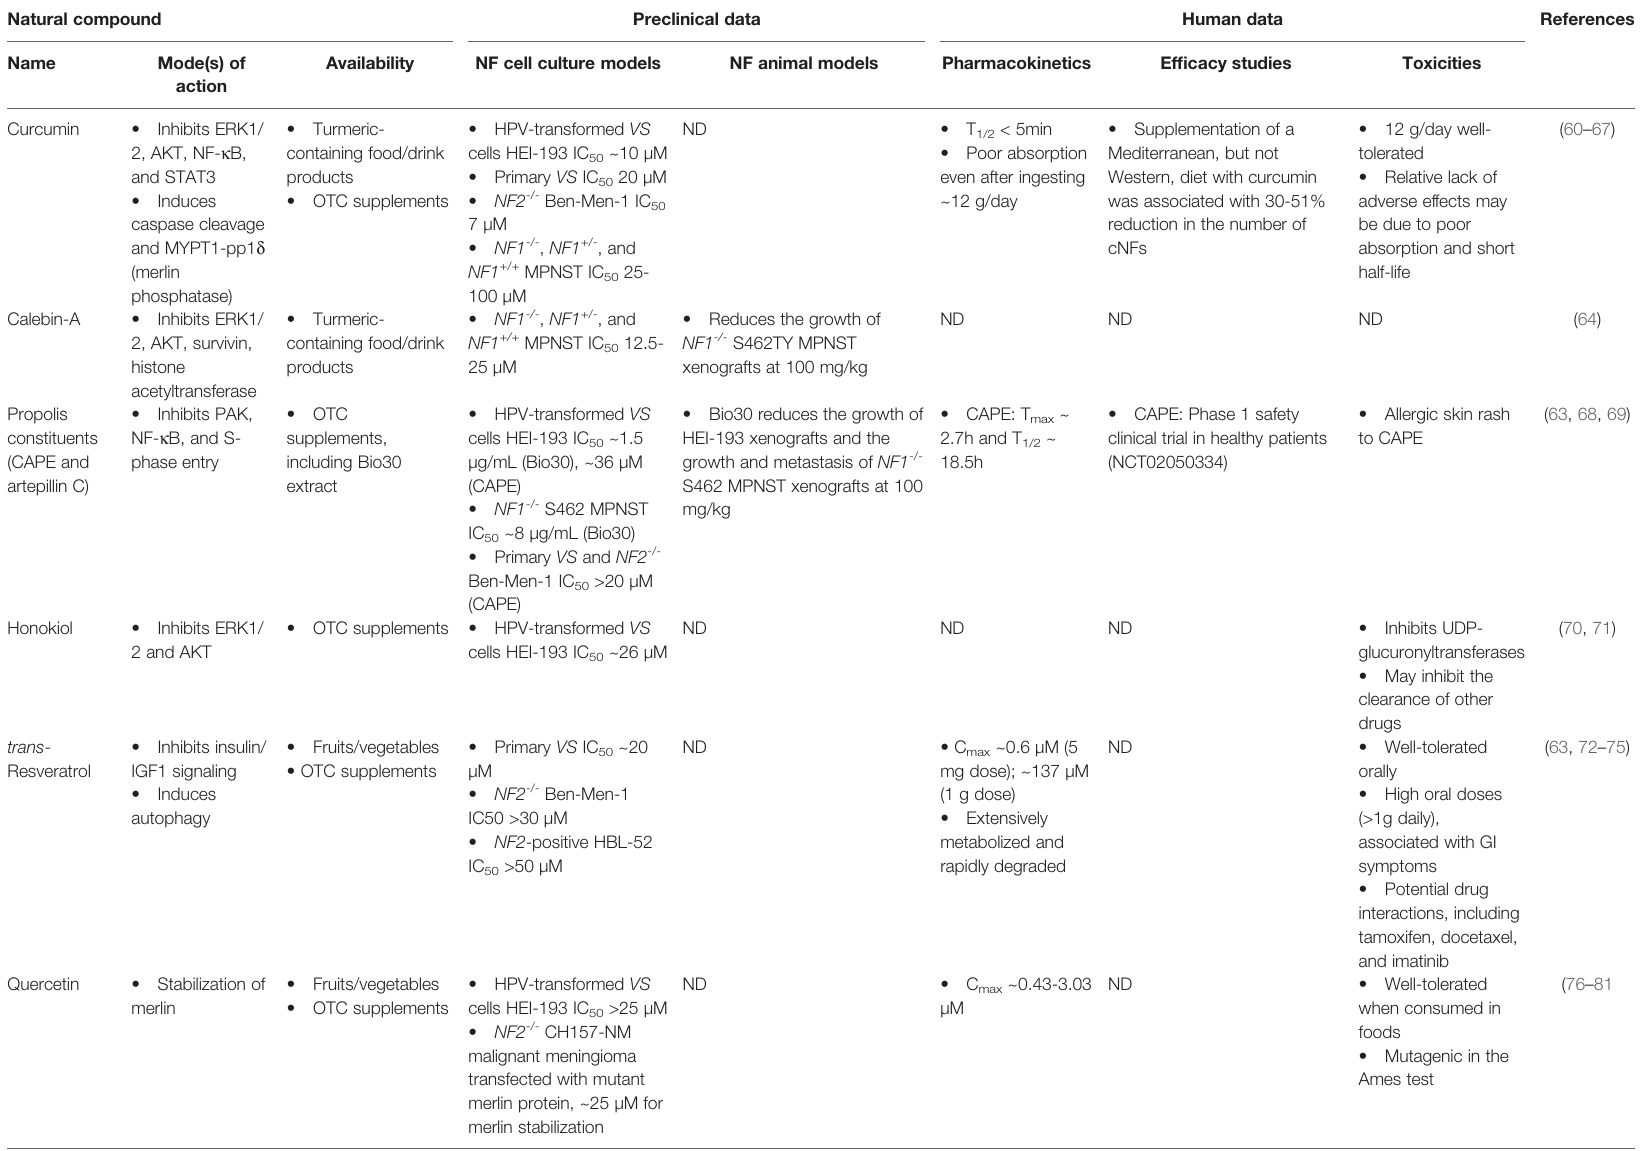
TABLE 1 | The natural compounds evaluated in NF-related models and their mechanisms of action, preclinical data, and human evaluation. Natural